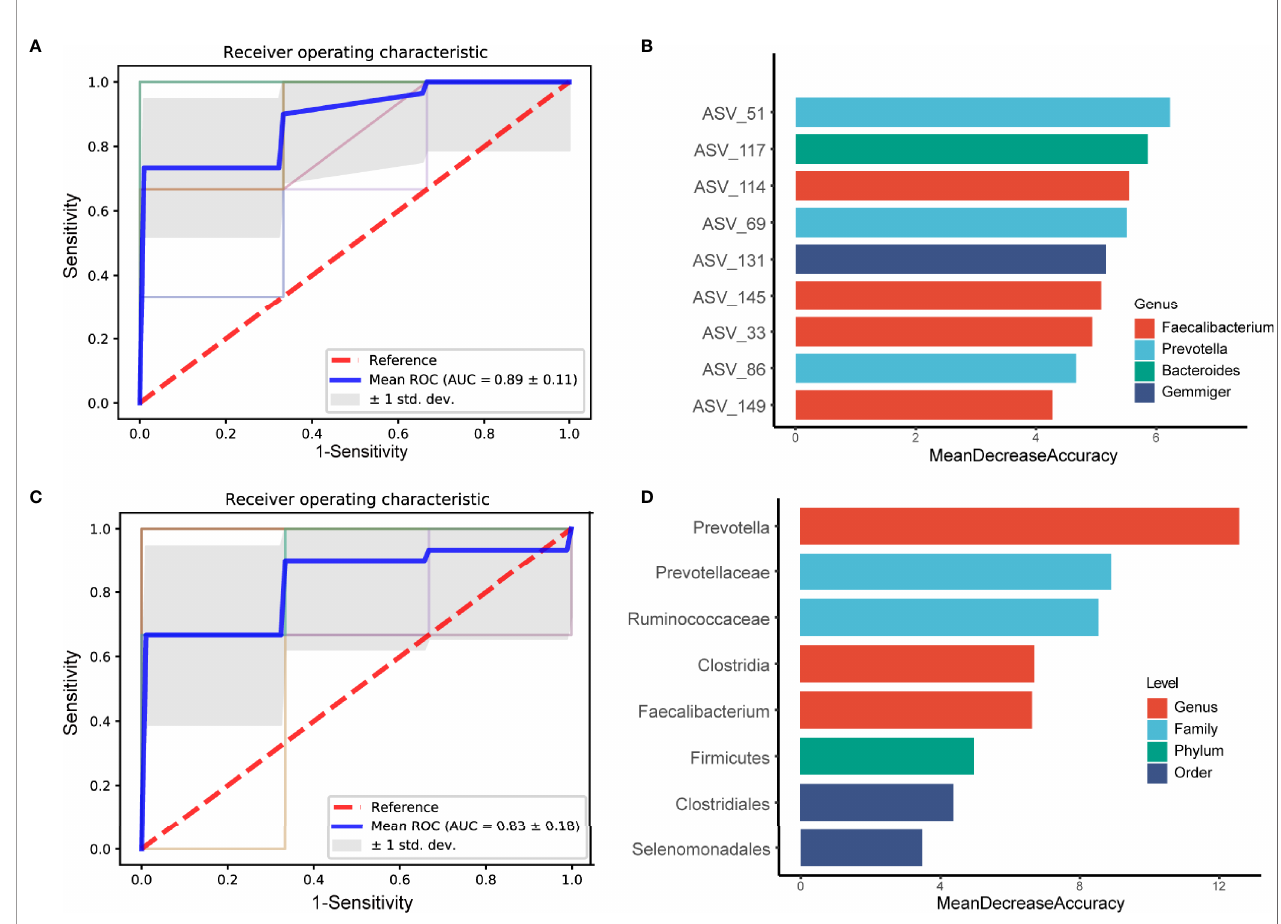
FIGURE 5 | Diagnostic outcomes are shown via receiver operating characteristic (ROC) curves for PDC and BC. A, C. Random Forest models are constructed using explanatory variables of ASVs (A) and taxon (C) . (B, D) The detailed explanatory variables based on the random forest model in each comparison. The lengths of the bars in the histogram represent the mean decrease accuracy, which indicates the importance of the ASVs or taxon for classi fi